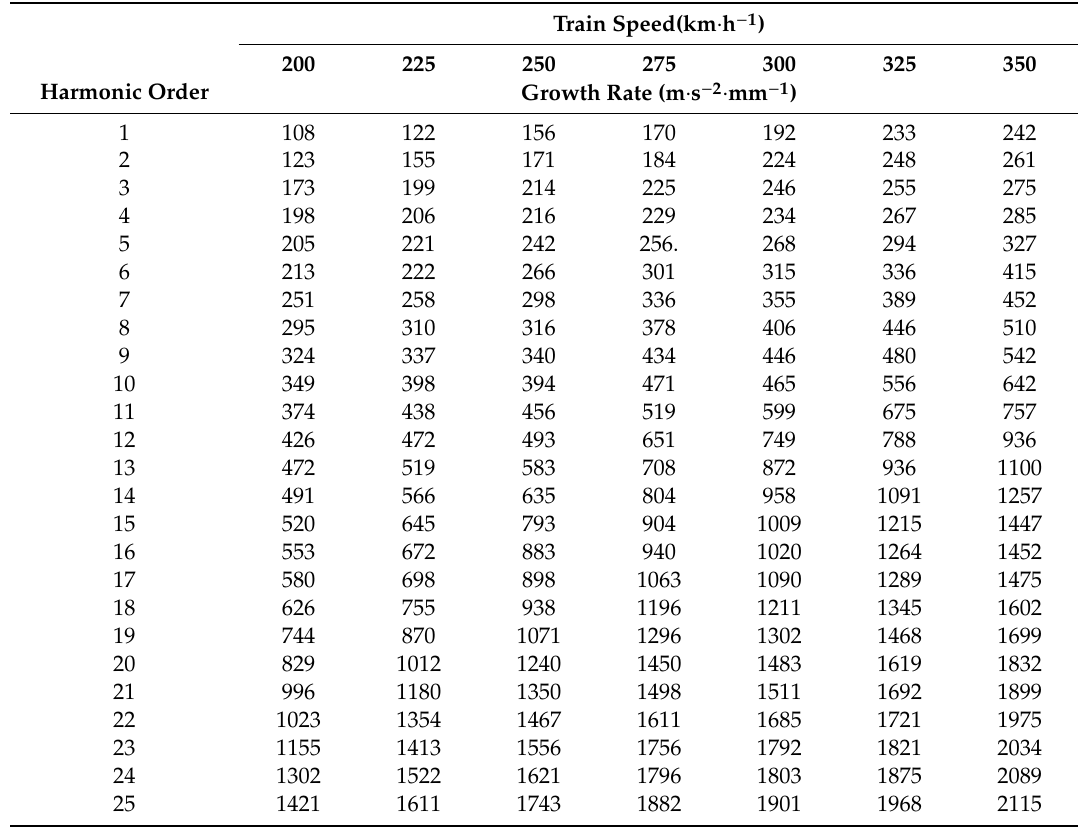
Table 2. Growth per unit OOR amplitude of axle-box acceleration due to polygonized wheels, in m · s − 2 · mm − 1 .